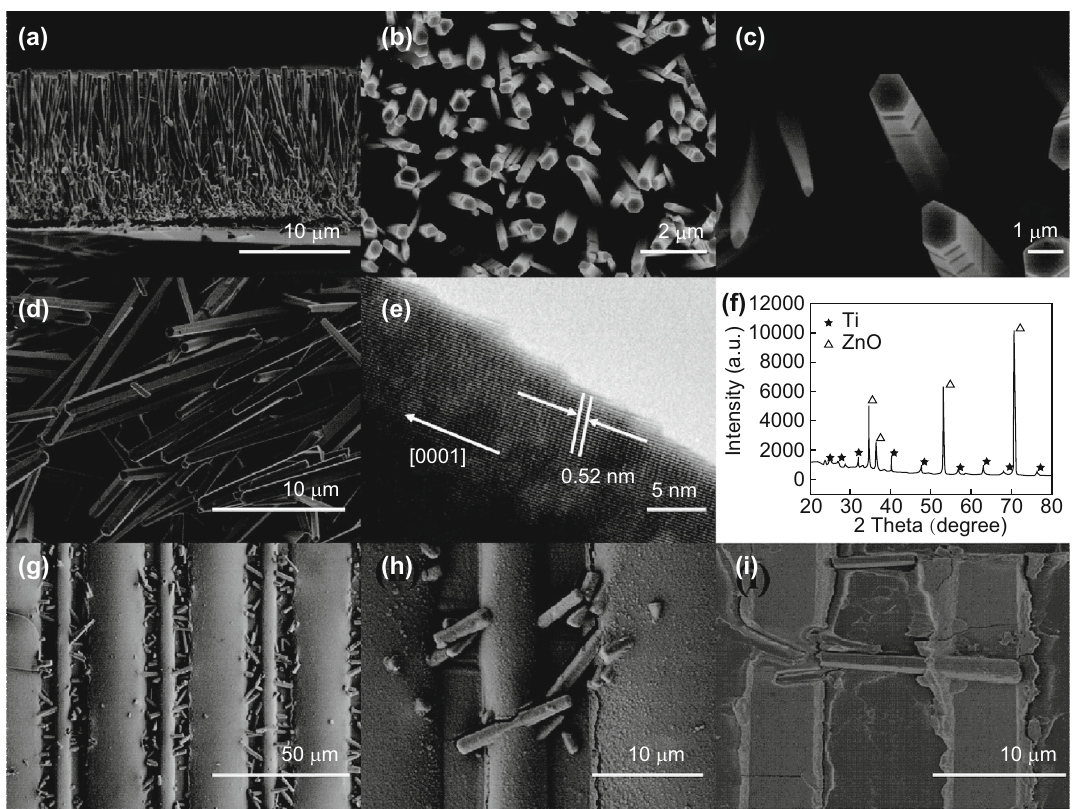
Fig. 2 a SEM image of as-grown ZnO nanowire arrays on Ti substrate on the side view. b , c Top-view SEM images of as-grown ZnO nanowire arrays. d SEM image of ZnO horizontally aligned nanowire arrays (overwhelmed in one direction) before smearing on Kapton substrate. e High- resolution TEM image of one single ZnO nanowire. f XRD pattern of ZnO nanowires. g Top-view SEM image of the device (before washing with acetone). h , i Enlarged view of the